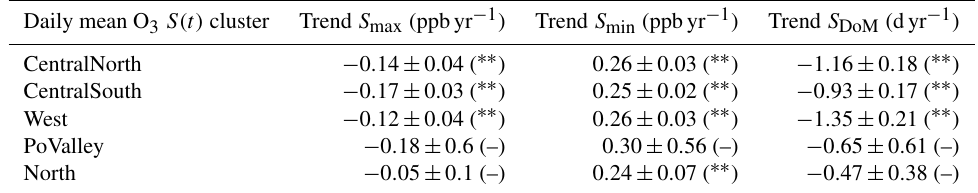
Table 2. Linear trends of S max , S min and S DoM for the daily mean O 3 S(t) clusters during 2000–2015: ∗∗ indicates a highly significant trend ( p value < 0.01), and – indicates a nonsignificant trend ( p value >